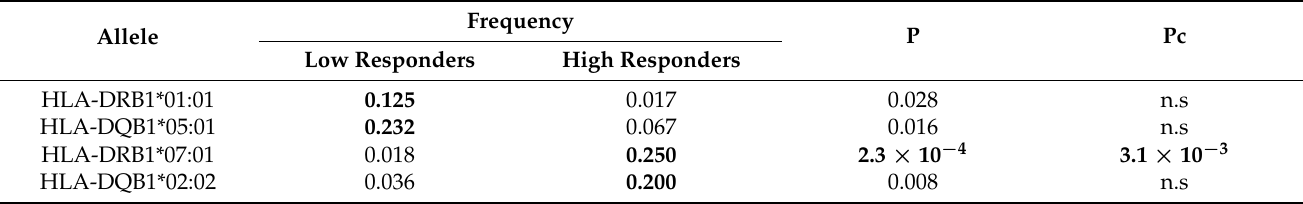
Table 2. Comparison of allele frequencies.